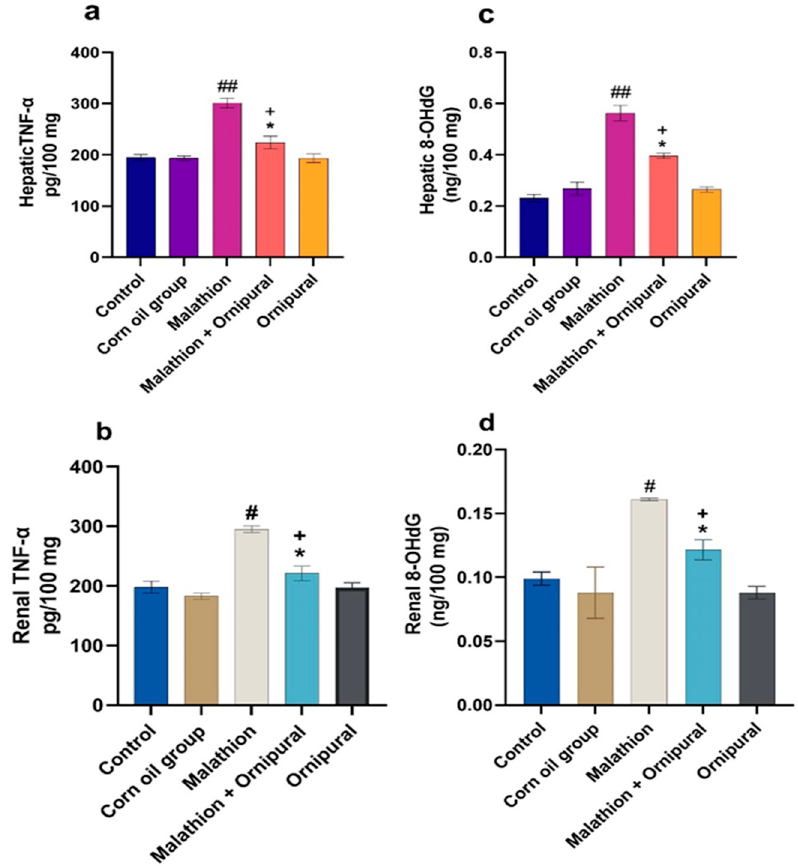
Figure 5. Modulatory effect of Ornipural ® against malathion-induced inflammation in hepatic and renal tissue ( a ) hepatic TNF- α ( b ) renal TNF- α ( c ) hepatic 8-OHdG ( d ) renal 8-OHdG. Data are ex-